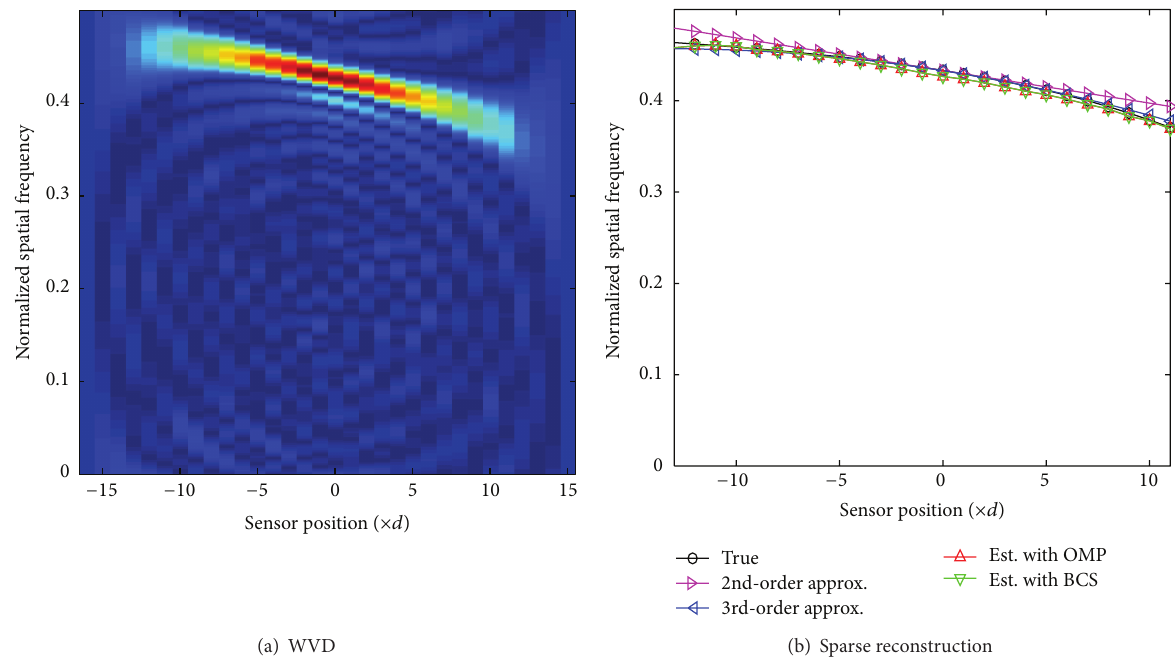
Figure 7: Near-field source location estimation using the ULA ( 𝑟 1 = 350 m, 𝜃 1 = 30 ∘